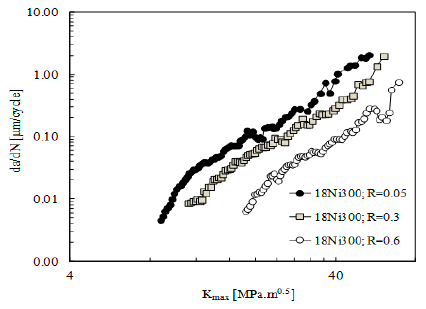
Figure 3. da/dN-K max curves (18Ni300 steel; t = 6 mm). Figure 3. da / dN-K max curves (18Ni300 steel; t = 6